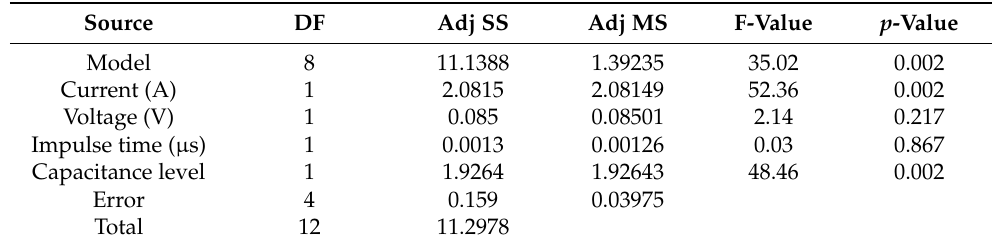
Table 7. Statistical analysis (ANOVA) of the influence of machining parameters on surface quality for 90–270 ◦ orientation.